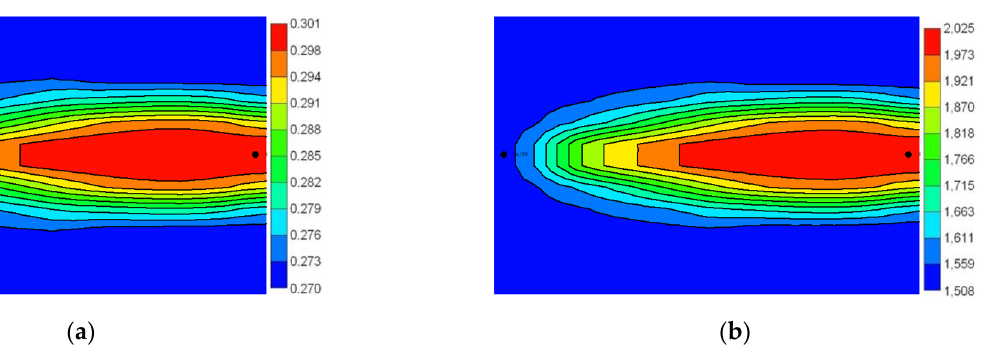
Figure 15. Physical property distribution between two wells after steam flooding. ( a ) Porosity distribution; ( b ) permeability distribution.